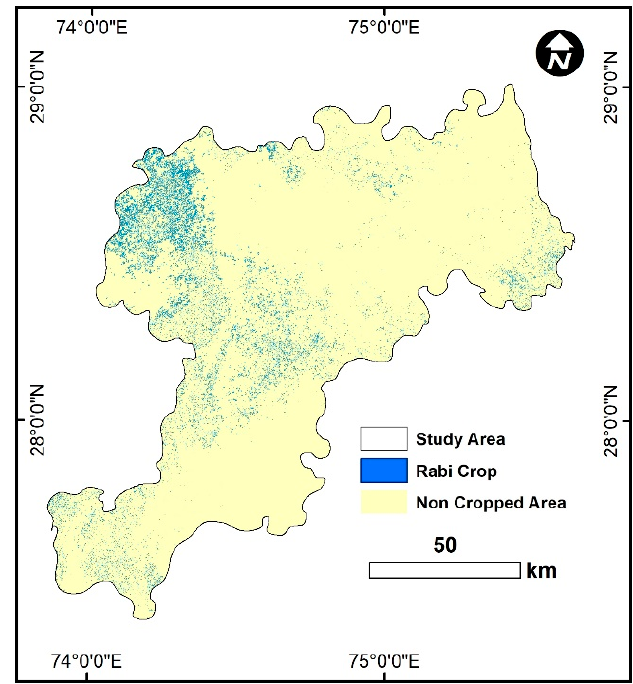
Figure 8. Rabi crop distribution (Datum: WGS84).